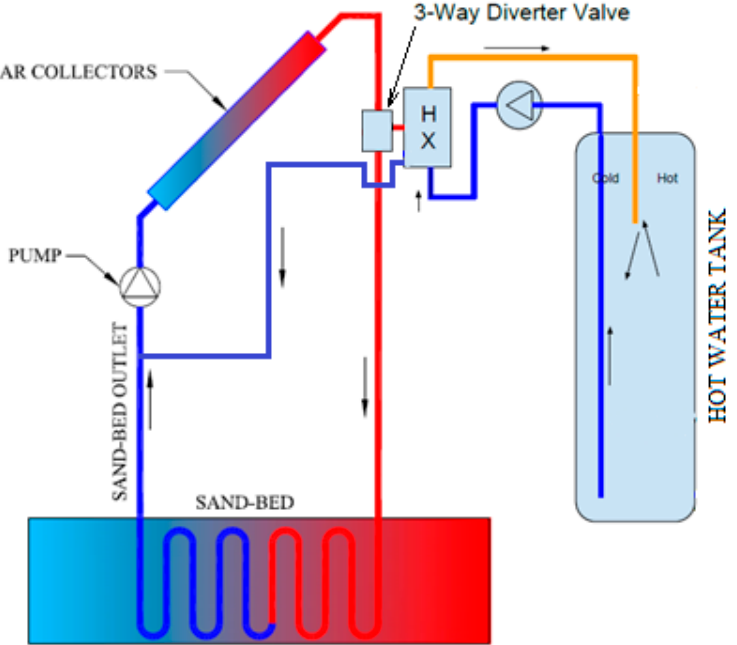
Figure 2. Solar thermal storage system piping diagram [15].